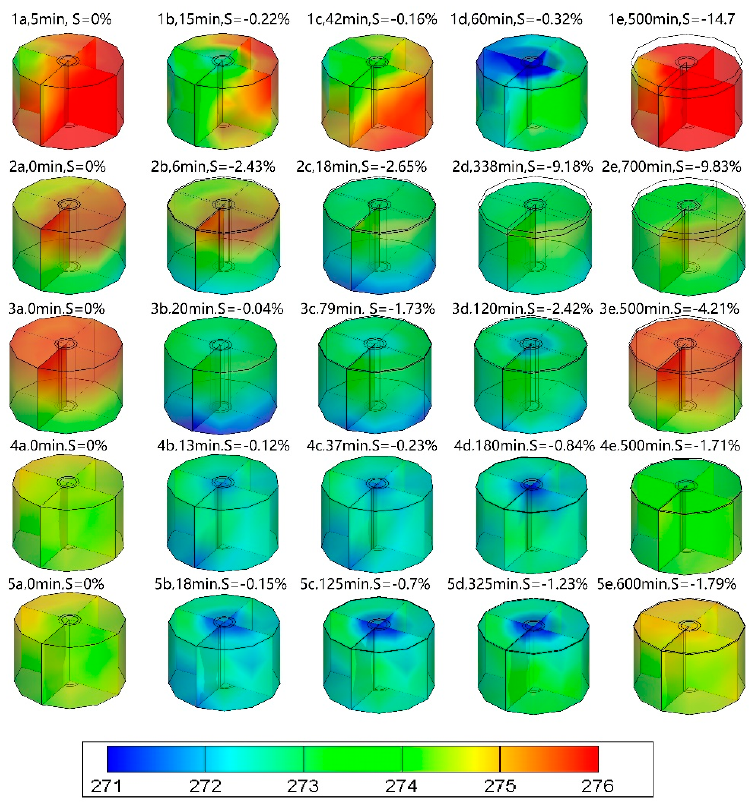
Figure 5. Spatial distribution of heat for five experiments (Experiment number, Production time (min), Subsidence ratio (S, %)).